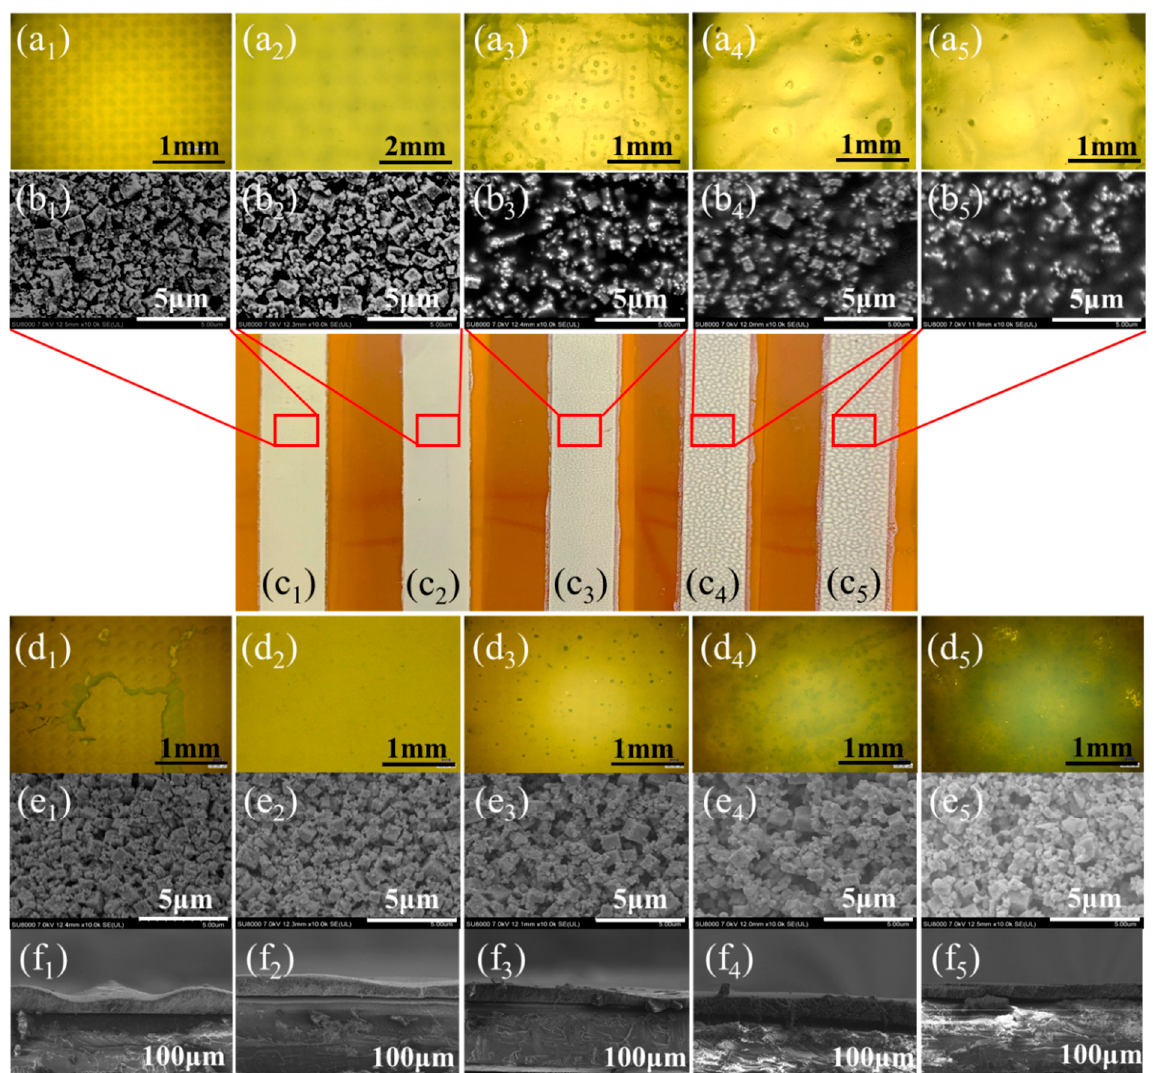
Figure 3. The optical and SEM images under different preparation parameters: ( a ) Morphology of groups 1–5 samples cured at 150 °C for 15 min after printing twice; ( b ) The SEM images of 1–5 samples before the heat treatment; ( c ) Macroscopic images of 5 groups of samples fabricated on the flexible substrates; ( d ) Morphology of groups 1–5 samples cured at 35 °C for 60 min; ( e ) The SEM images of 1–5 samples after the heat treatment; ( f ) The SEM images of the cross-section view of 1–5 samples.